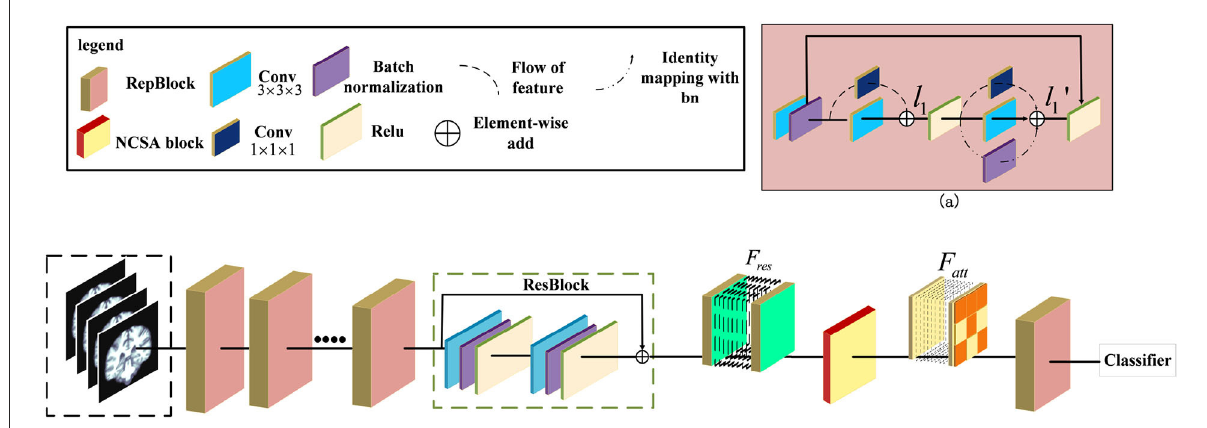
FIGURE1 Illustration of the pipeline for Alzheimer’s Disease classification. The ResRepANet consists of several ResRepBlocks, ResBlock, and a Non-local Context Spatial Attention (NCSA) block. (a) Structure of ResRepBlock, where the feature l 1 extracted from the convolution module with kernel size 3 × 3 × 3 and 1 × 1 × 1 as well as the feature l ′ 1 extracted from two convolution modules and identity mapping.